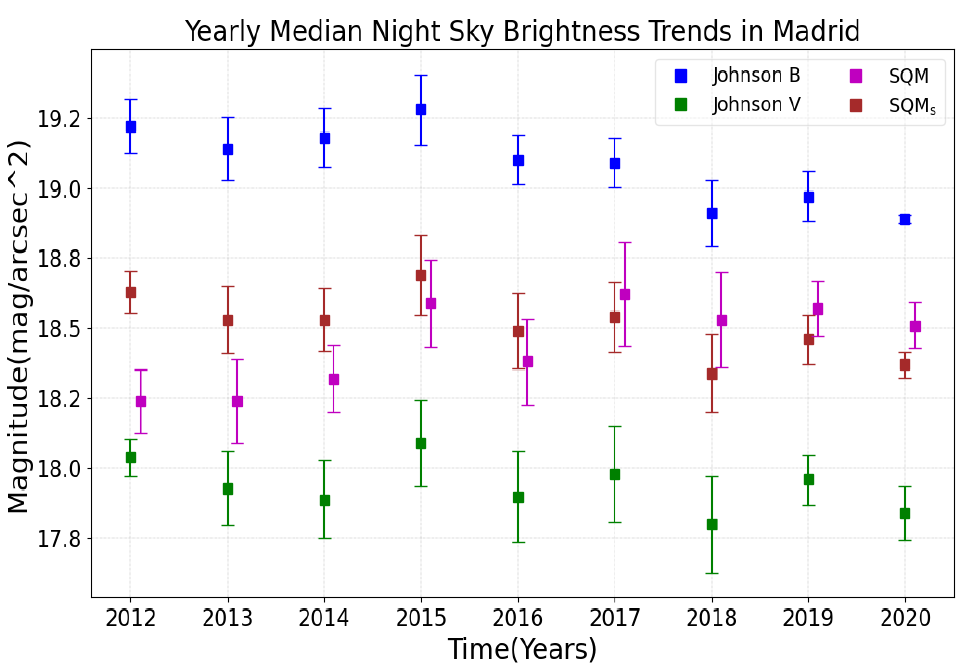
Figure 15. Comparison of the evolution of the yearly median values after midnight of the Johnson B and V magnitude and the SQM. The brown points represent the synthetic SQM s obtained by combining V and (B-V) data. Table 2. Comparison SQM and synthetic SQM (mag/arcsec 2 ).